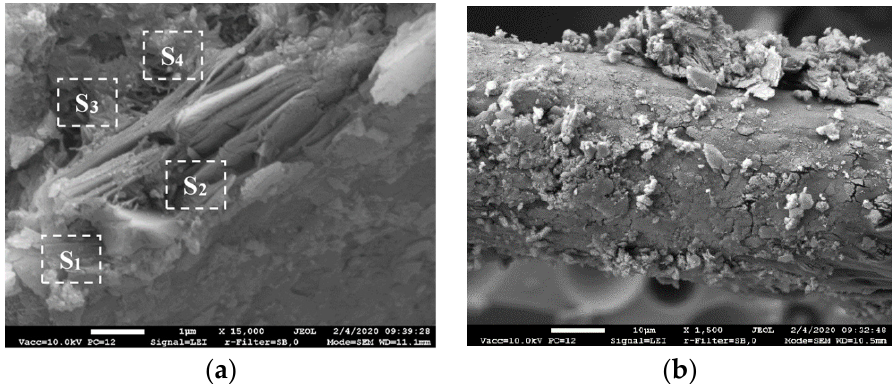
Figure 12. Characteristic microstructure of hardened blended cement paste: S1–S4 the area of EDX analysis ( a ) and pulled out PVA fiber ( b ) .